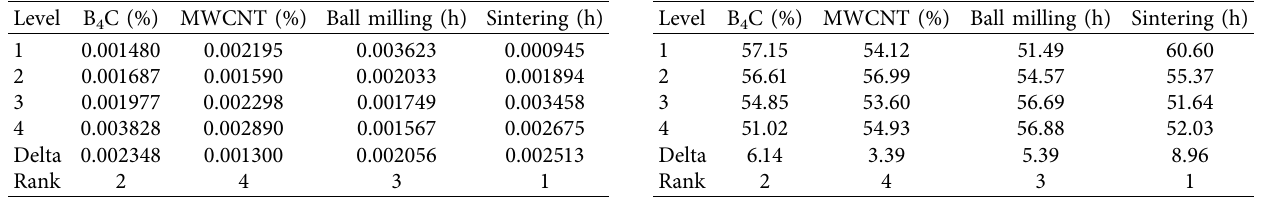
Figure 11: 3D Surface plot analysis for microhardness: (a) B sintering; (d) sintering vs. B 4 C %.